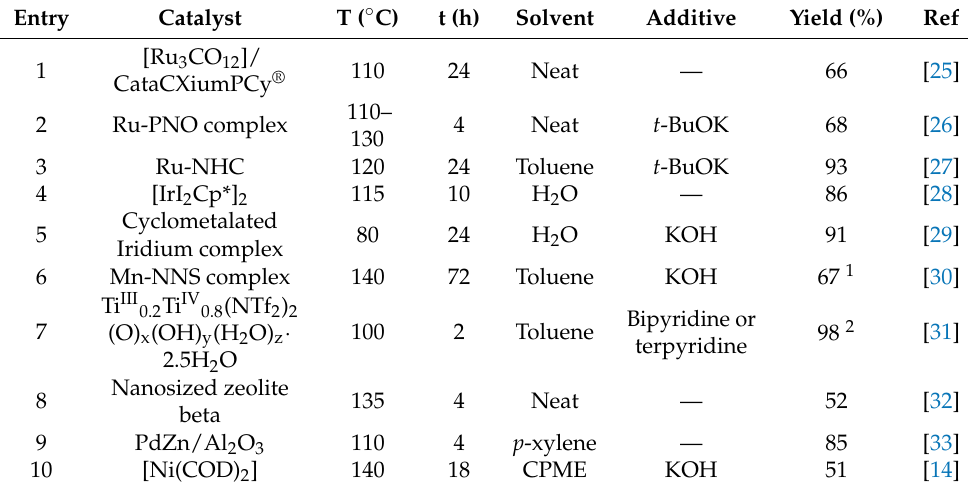
Table 2. Catalytic furfuryl alcohol amination with a primary amine as a nitrogen source.